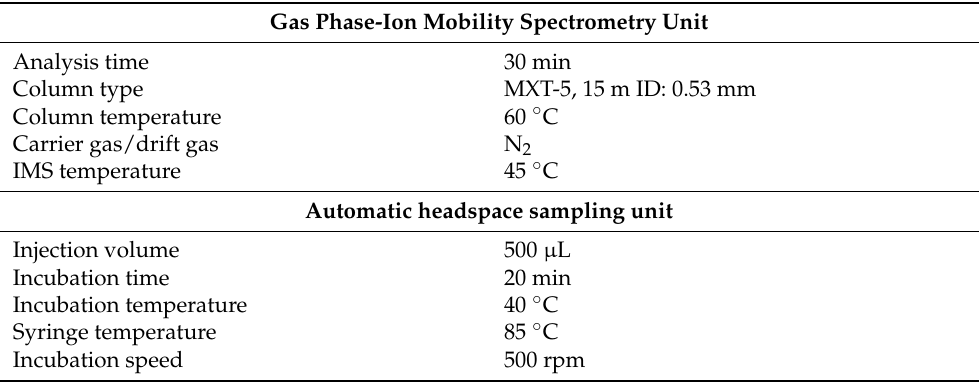
Table 2. Experimental conditions for tuna analysis by